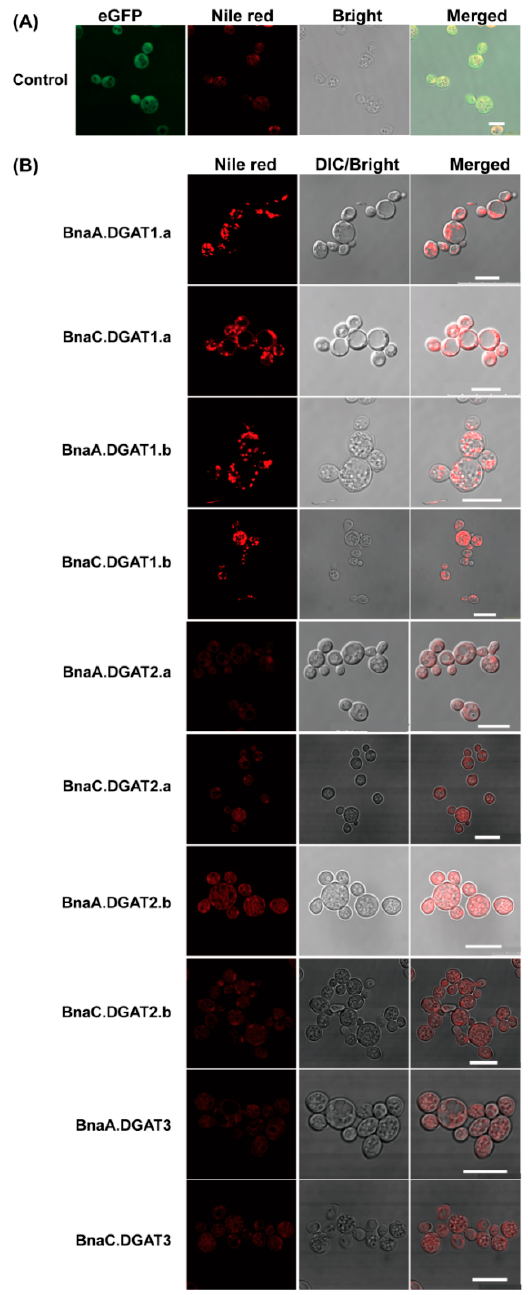
Figure 4. Oil bodies in S. cerevisiae H1246 expressing BnaDGATs by Nile red staining. ( A ) Negative control. Yeast H1246 expressing eGFP; ( B ) Yeast H1246 expressing different BnaDGATs . Oil droplets were observed in yeast H1246 expressing BnaDGAT1s but were not detectable and/or were very weak in yeast H1246 expressing BnaDGAT2s and BnaDGAT3s . Bar = 10 μ m.